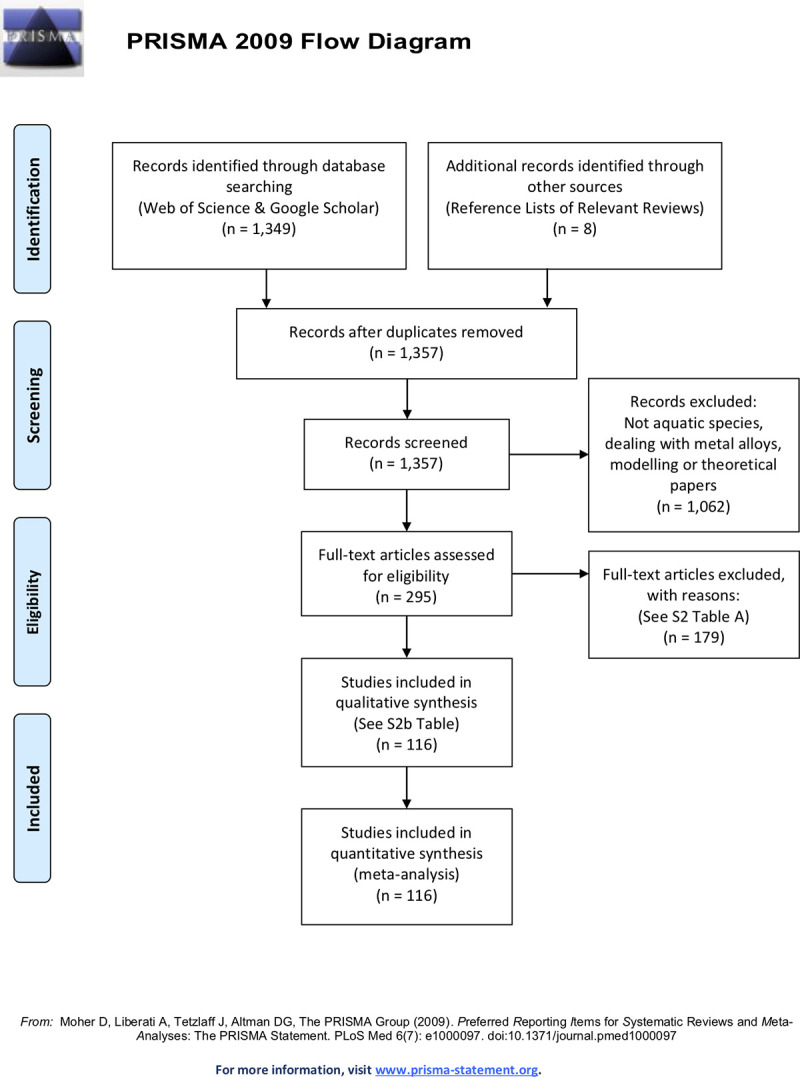
PRISMA flowchart providing the steps of data collection for the systematic review of evidence for bioaccumulation and biomagnification in a general marine food web.The review focussed on microplastics and associated chemical additives detected in marine species from coastal, pelagic, reef and deep-sea environments.